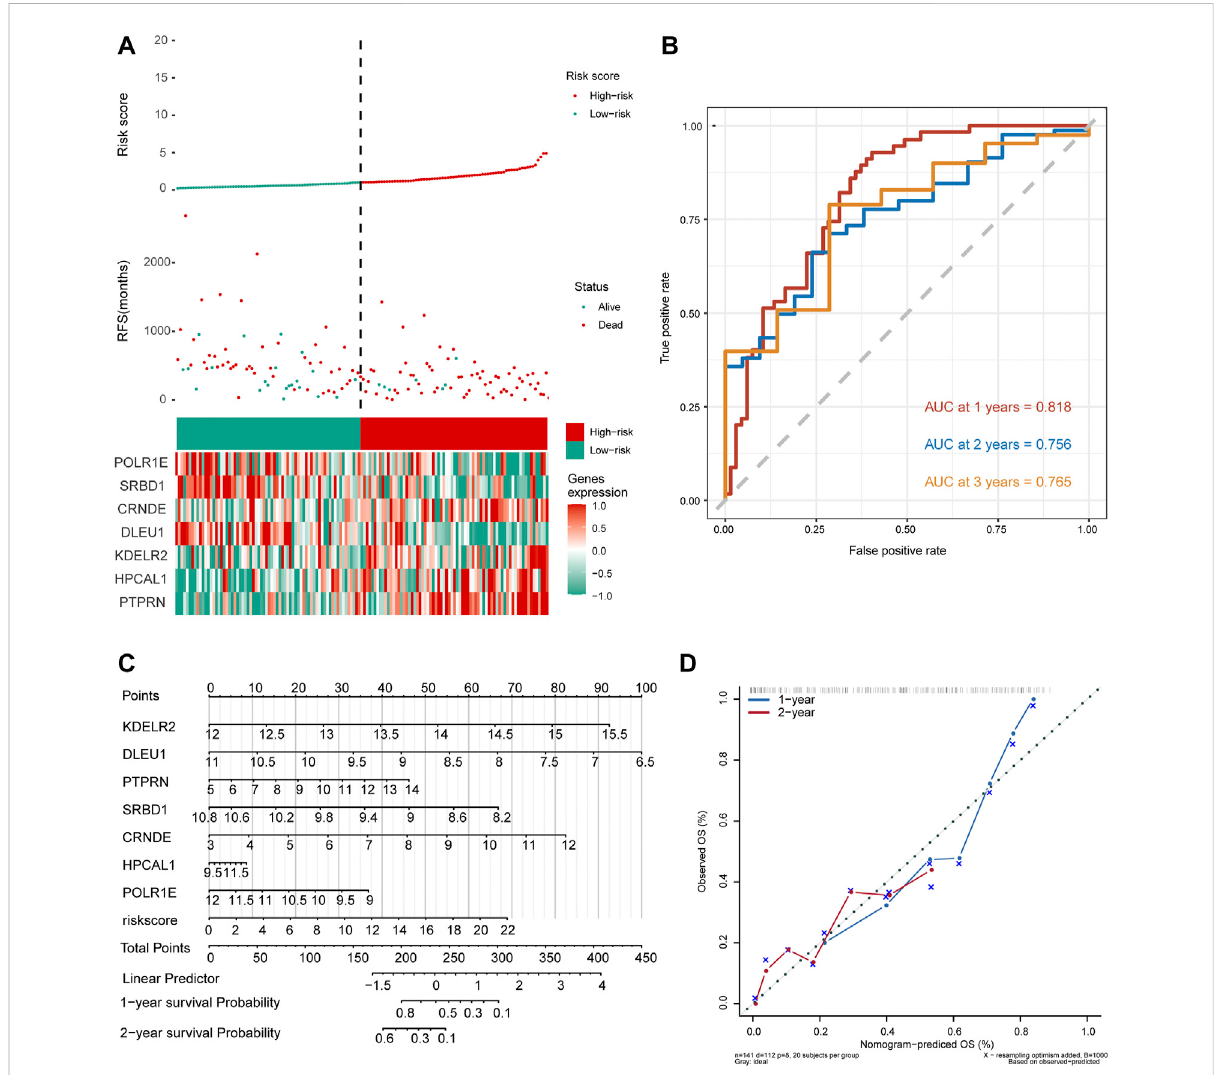
FIGURE 5 Sevenhubgene-riskscoreswereconstructedbasedonthemedianriskscore. (A) Distributionofglioblastoma(GBM)patientsandsurvivalstates of GBM patients with the risk scores, heat-map of seven hub genes. (B) Time-dependent receiver operating characteristic (ROC) analysis in The Cancer Genome Atlas for median of risk score in GBM. AUC, area under the curve. (C) The nomogram was built by seven hub genes. (D) The calibration plots for internal validation of the nomogram for 1- and 2-year survival. OS, overall